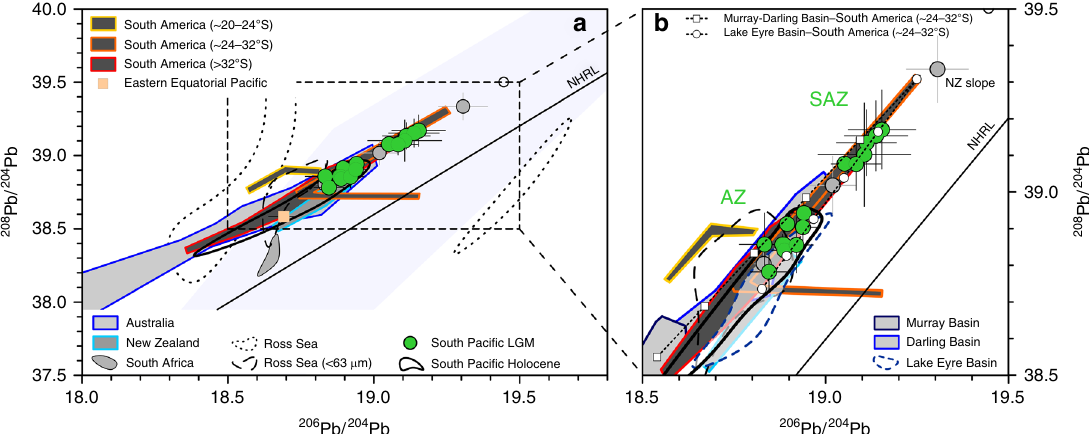
Fig. 3 South Paci fi c Last Glacial Maximum fi ne fraction samples in 208 Pb/ 204 Pb- 206 Pb/ 204 Pb space. Remote open ocean samples in green and locations at/near the continental margins in gray. Last Glacial Maximum (LGM) data points and error bars represent averages and their 2 SD across the LGM interval (~18 – 24 ka BP). Black ring indicates coretop sample PS75/105-1 from the New Zealand shelf 34 . See Supplementary Fig. 1 and Supplementary Tables 2 and 3 for details and references to potential source area (PSA) data. a Overview of Southern Hemisphere PSA compositions. Average LGM value for the Eastern Equatorial Paci fi c from ref. 71 . Light blue shading indicates Dome C ice-core data 38 . NHRL: Northern Hemisphere Reference Line 97 . b Detailed view including endmember mixing models. Filled white symbols represent 20% increments of mixing of Central South America (24 ‒ 32°S) with Lake Eyre (circles) and Murray – Darling endmembers (squares), respectively. Australia is subdivided into individual provinces. AZ: Antarctic Zone. SAZ: Subantarctic Zone. It is noteworthy that one Central South American sample is depleted in 208 Pb relative to 207 Pb (see Supplementary Fig. 4 for comparison), and that Lake Eyre Basin data were obtained from bulk sample material 38